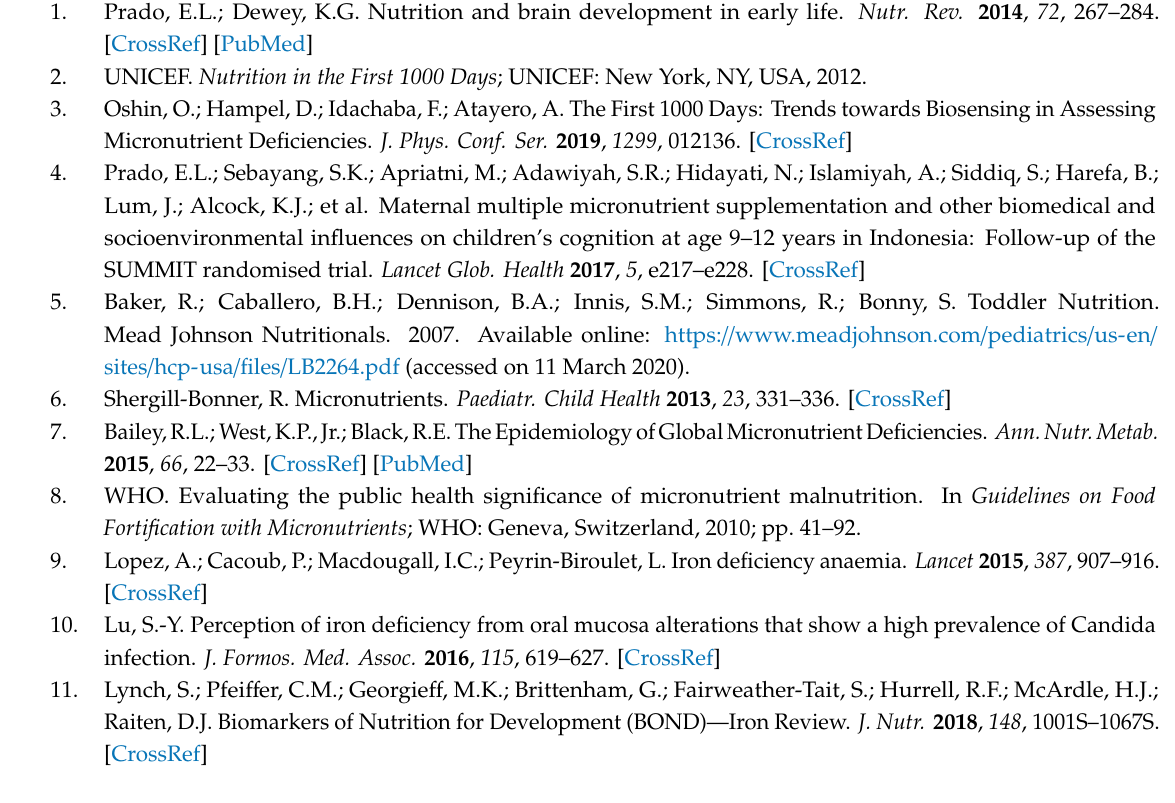
Figure S1: The IDE shadow mask pattern design specific for 4-inch wafer used in this work, Figure S2: GFET functionalization process, Figure S3: Liquid-gated FET Setup, Figure S4: Raman shift for CVD-synthesized monolayer graphene, Figure S5: Shift of I-V curve upon di ff erent stages of functionalization of another device (#7). (a) Shows initial I-V curve, as well as upon functionalization with PASE + antibody, passivation, and addition of target ferritin biomolecule of 8 ng / mL concentration. (b) Shows the change in the I-V curve upon final step, of addition of specific ferritin biomolecules Table S1: Ferritin concentration and the equivalent bound